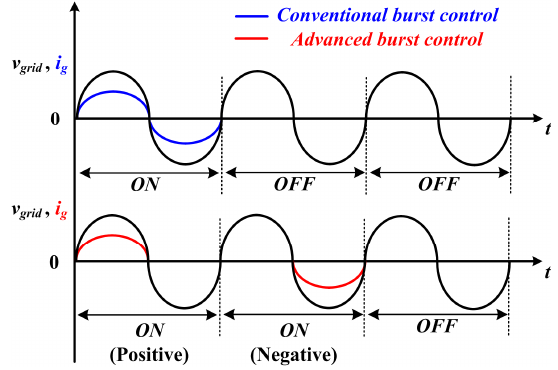
Figure 10. Conventional and advanced burst control schemes.